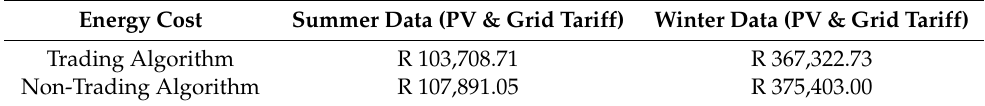
Table 2. Overview of energy cost for the optimal episode in the case studies considered. Energy Cost Trading